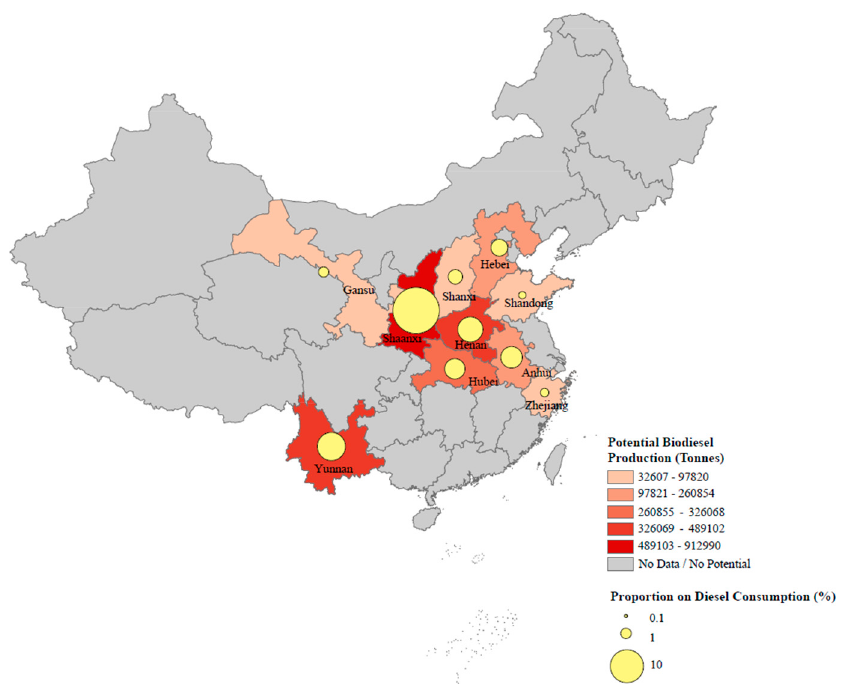
Figure 5. Annual potential biodiesel production in Chinese provinces cultivating Pistacia chinensis forests correlates with a decrease in total diesel consumption in those regions.